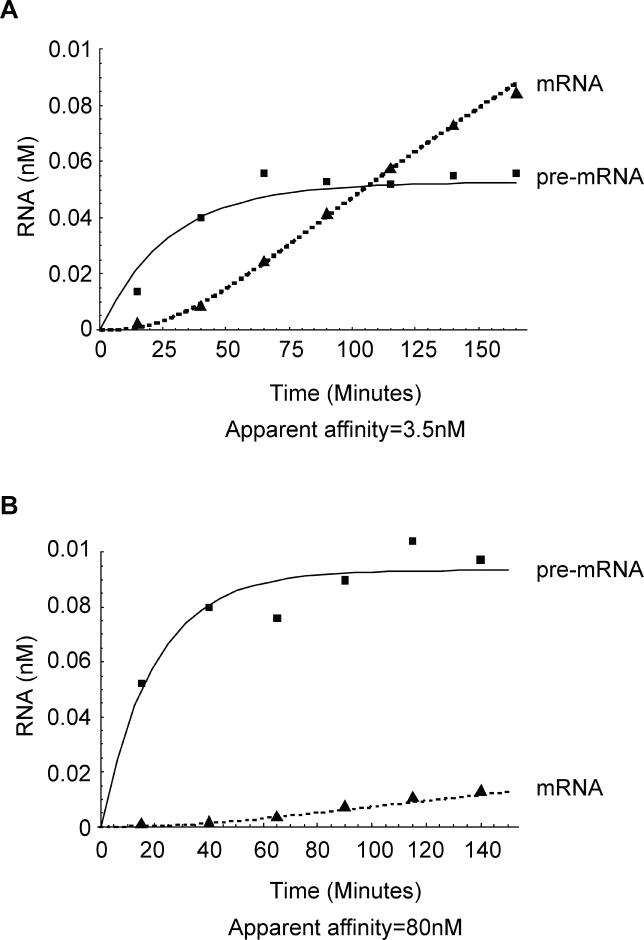
The Link between Pol II Transcription and Pre-mRNA Splicing Increases the Affinity of Splicing Factors to the Nascent Pre-mRNAA mathematical model is used to describe the basic reactions involved in the coupled transcription/splicing reaction. The splicing profiles obtained from RNAs generated by Pol II (A) or by T7 polymerase (B) were fit to the mathematical prediction by testing various affinities (K
m) between the splicing machinery and the pre-mRNA. (A and B) represent the best fit for either reaction. Squares represent pre-mRNA and triangles represent spliced mRNA. The solid line represents the mathematical prediction for the accumulation of pre-mRNA based on the K
m value indicated below each graph. The dotted line represents the mathematical prediction for the accumulation of spliced mRNA based on the K
m value indicated below each graph.